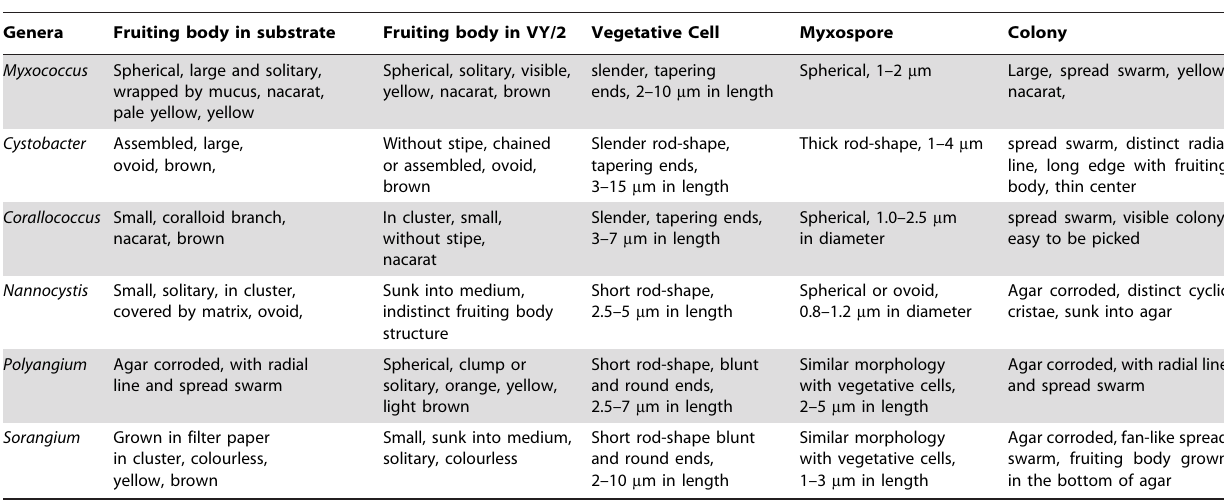
Table 3. Morphological characteristics of the isolated myxobacteria.